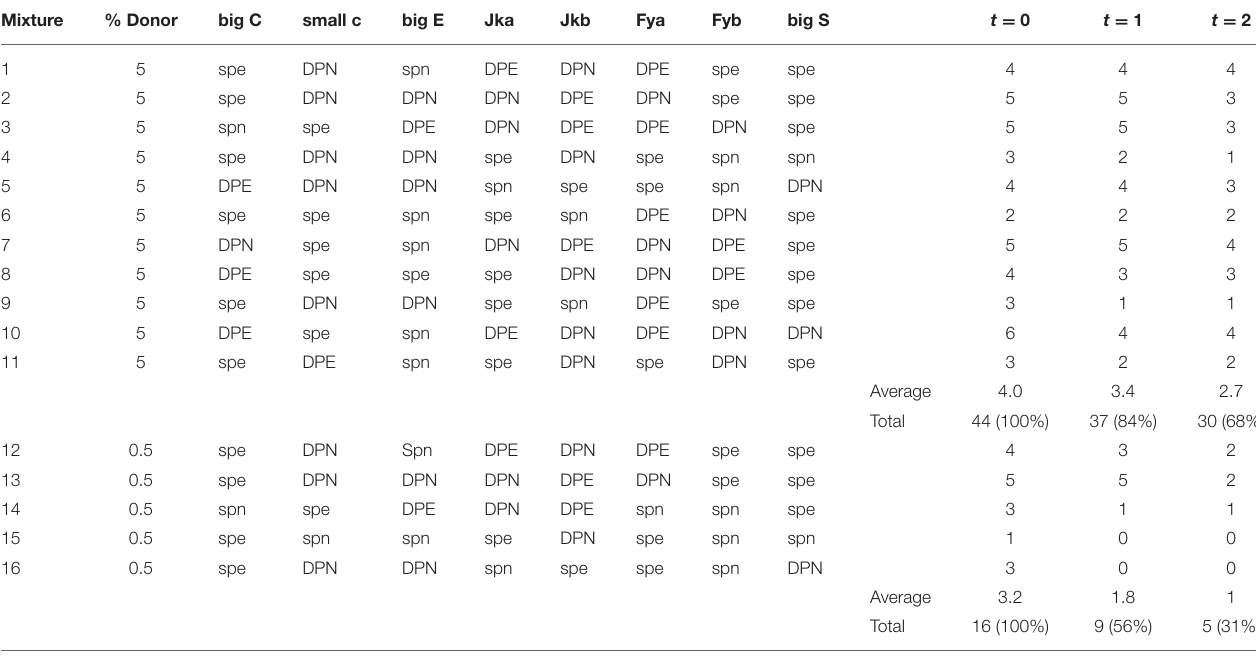
TABLE 2 | Result of the stability study over the 60 days period.